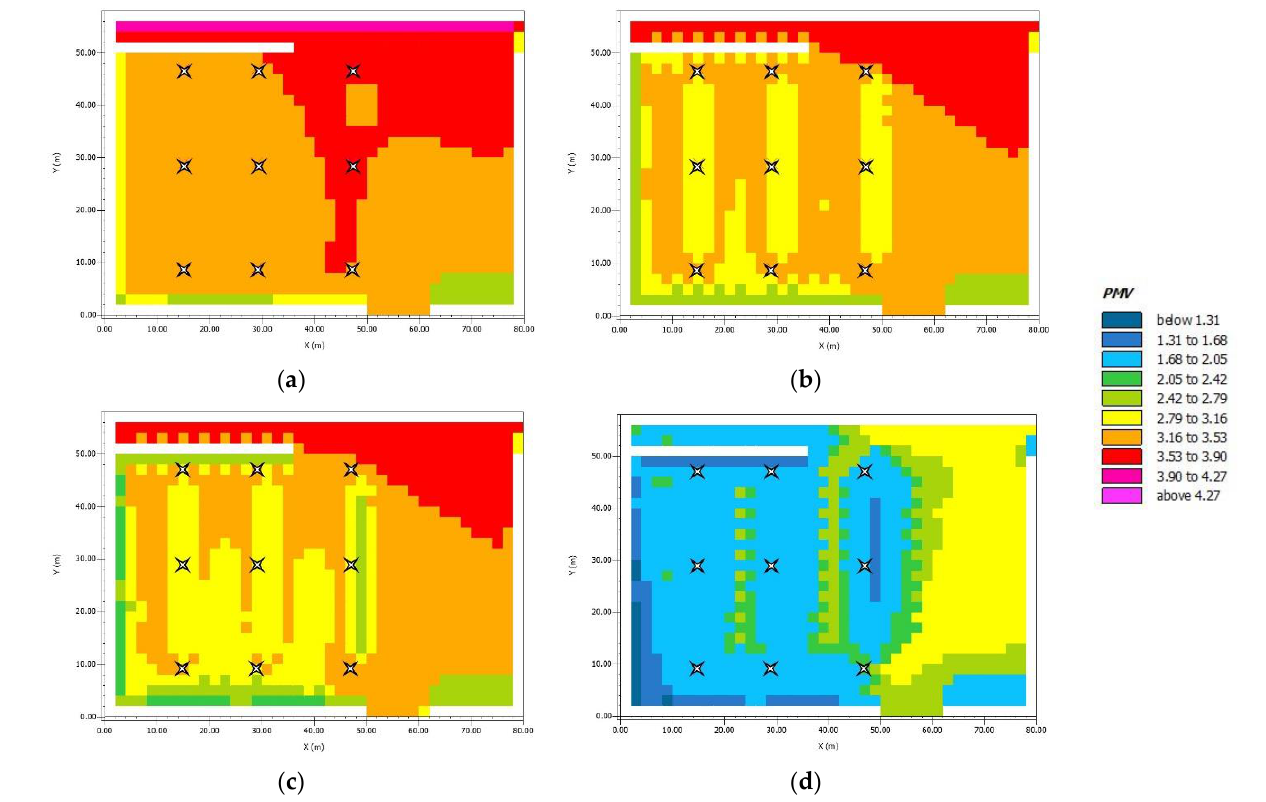
Figure 12. PMV at 12.00 a.m. in July. ( a ) AS; ( b ) LC+G1; ( c ) LC+G2; ( d ) LC+G3.